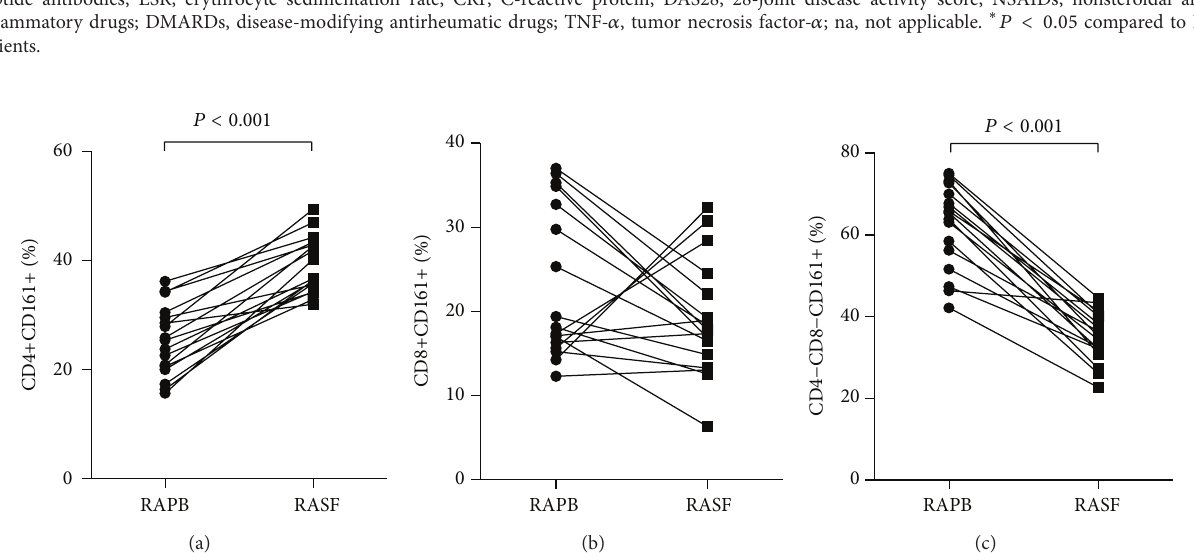
Figure 2: The percentages of CD4+CD161+ (a), CD8+CD161+ (b), and CD4 − CD8 − CD161+ T cells (c) in paired RA PB and SF samples are shown. P values were assessed by Wilcoxon matched pairs signed rank sum